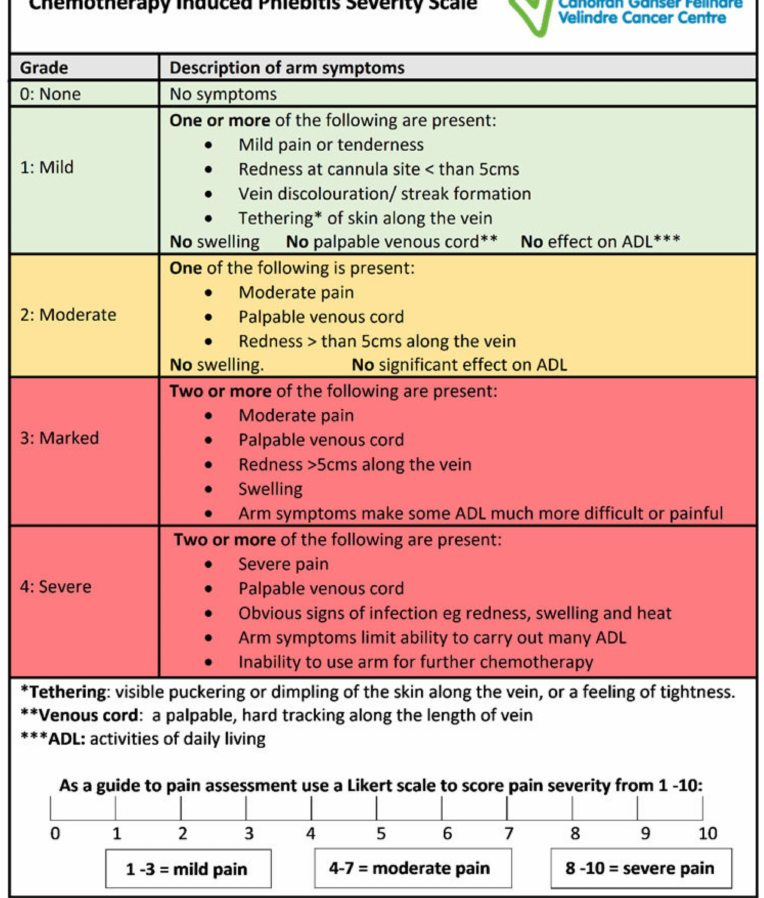
Figure 2. The chemotherapy-induced phlebitis severity scale.